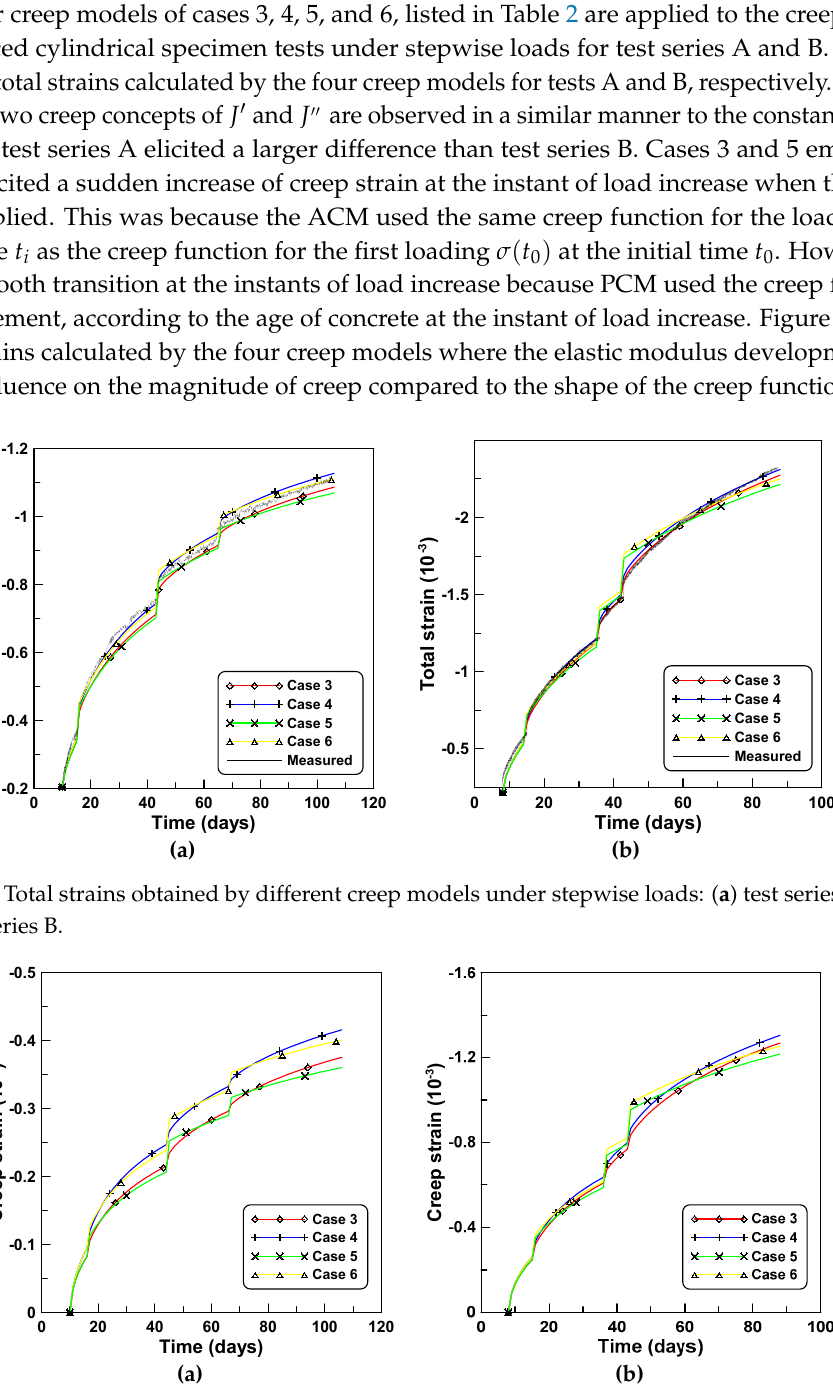
Figure 3. Shrinkage and creep strains elicited by different creep models under constant loads: ( a ) test series A and ( b ) test series B.